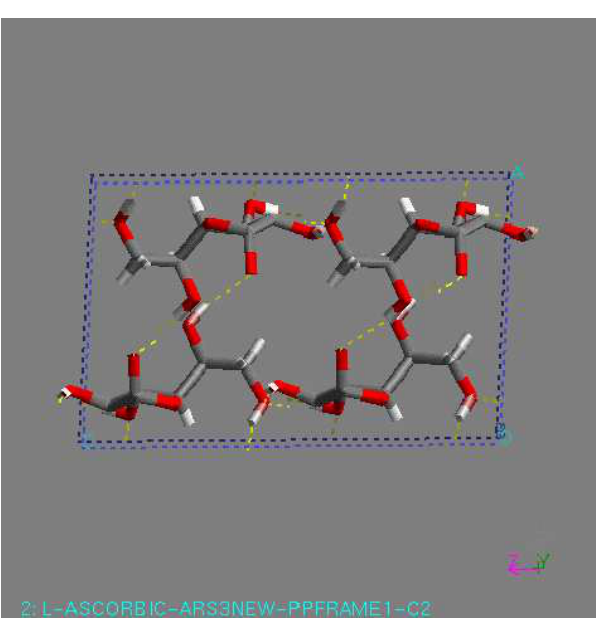
Figure 4. C2 structure, found by minimization. This structure had the lowest lattice energy in the DREIDING force field. View along the